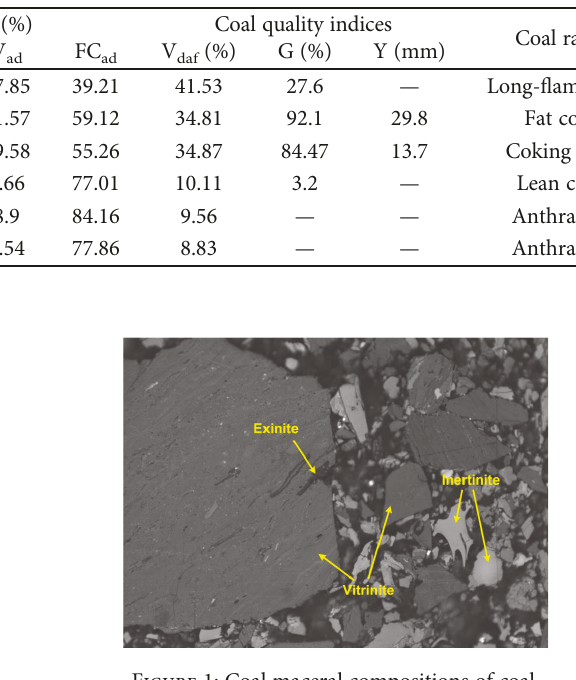
Figure 1: Coal maceral compositions of